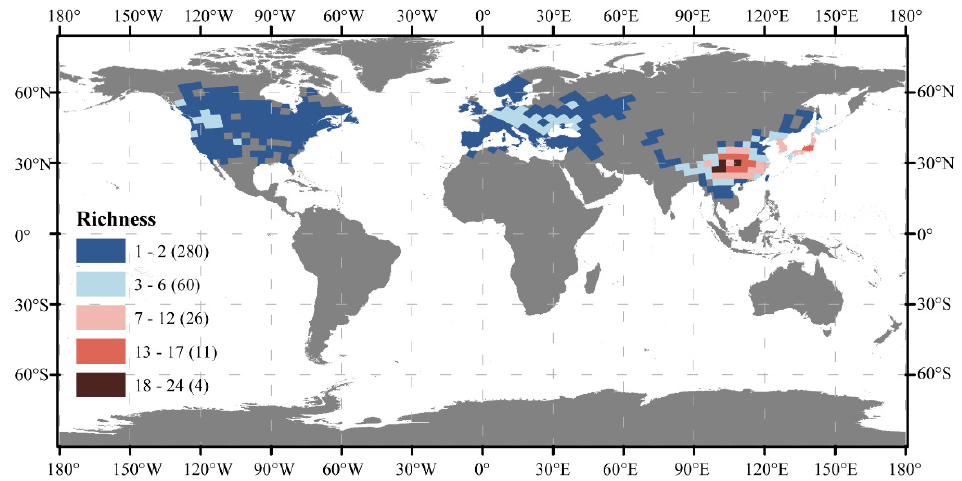
Figure 1. The map of species richness of subgenus Cerasus included 381 grid cells covering an area of 2.88 × 10 7 km 2 . Numbers in brackets indicate how many grid cell there are under that richness class.